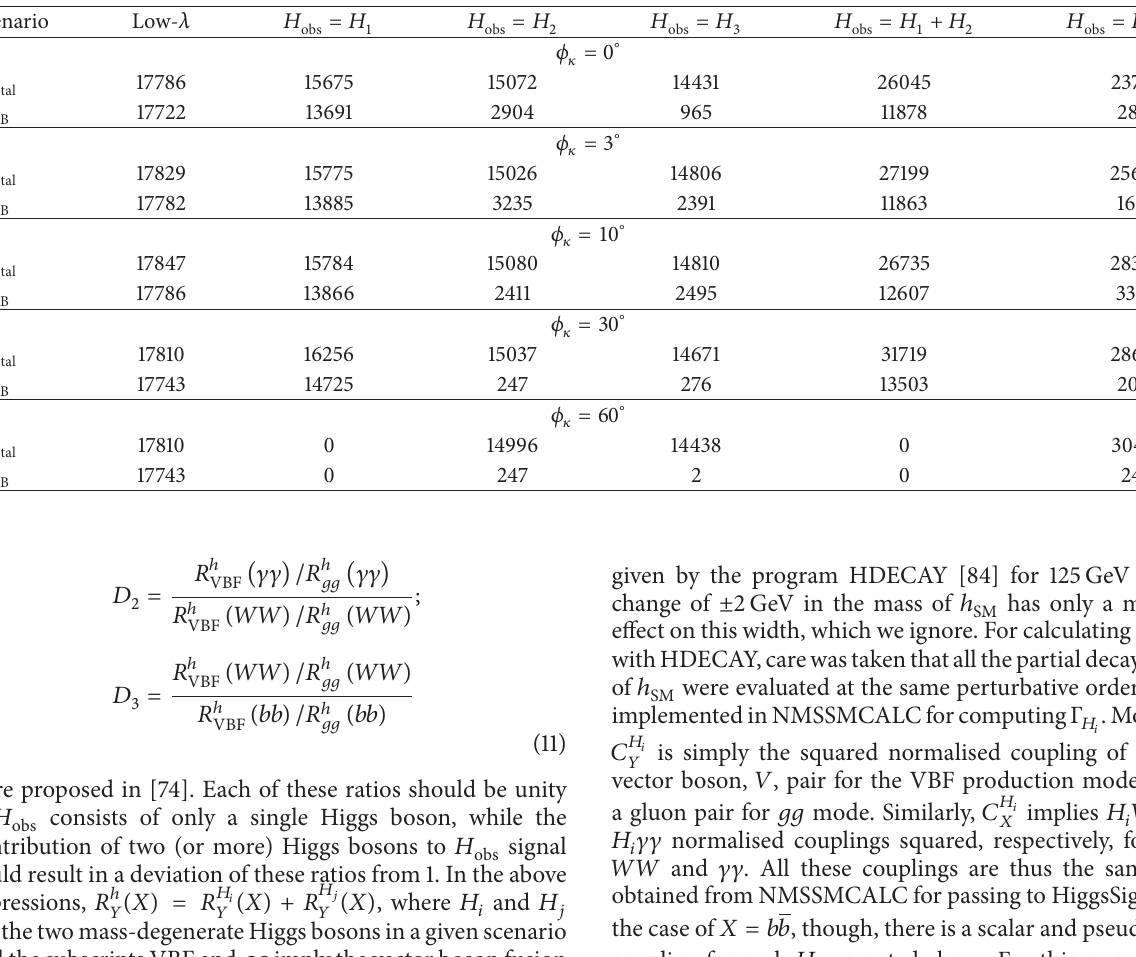
Table 2: Number of scanned points remaining after imposing the mass constraint on 𝐻 scenario studied. See text for